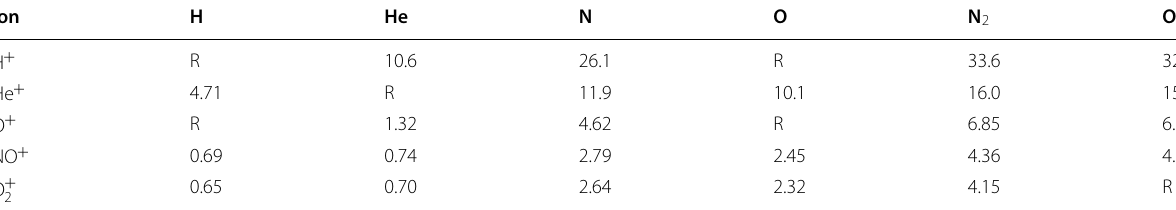
Table 1 Collision frequency coefficients C in × 10 10 for non-resonant ion-neutral interactions Ion H